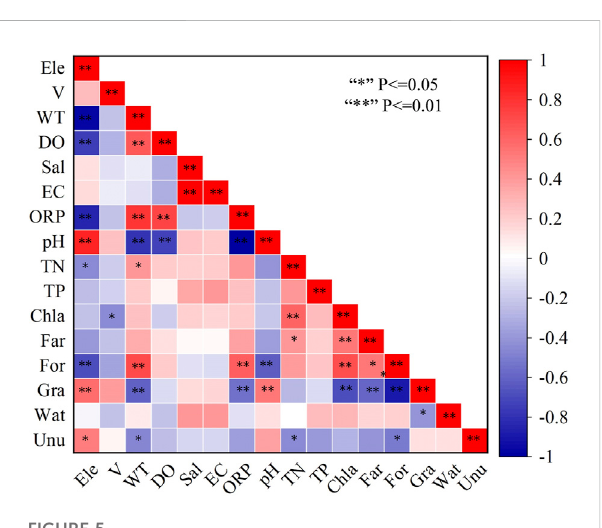
FIGURE 5 Heat map of the spearman correlation among LUT and